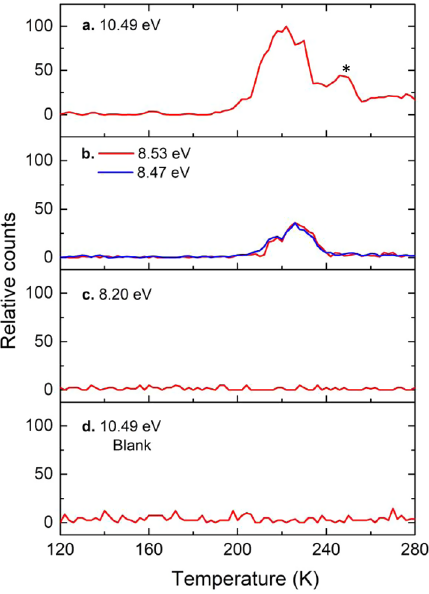
Fig. 4 PI-ReTOF-MS signals at m/z = 135 detected during the TPD phase of the electron processed phosphine – nitrogen ices. The data were recorded at photon energies of ( a ), 10.49 eV; ( b ), 8.53 eV and 8.47 eV; ( c ), 8.20 eV; ( d ), blank, 10.49 eV. The peak marked with an asterisk is not unambiguously